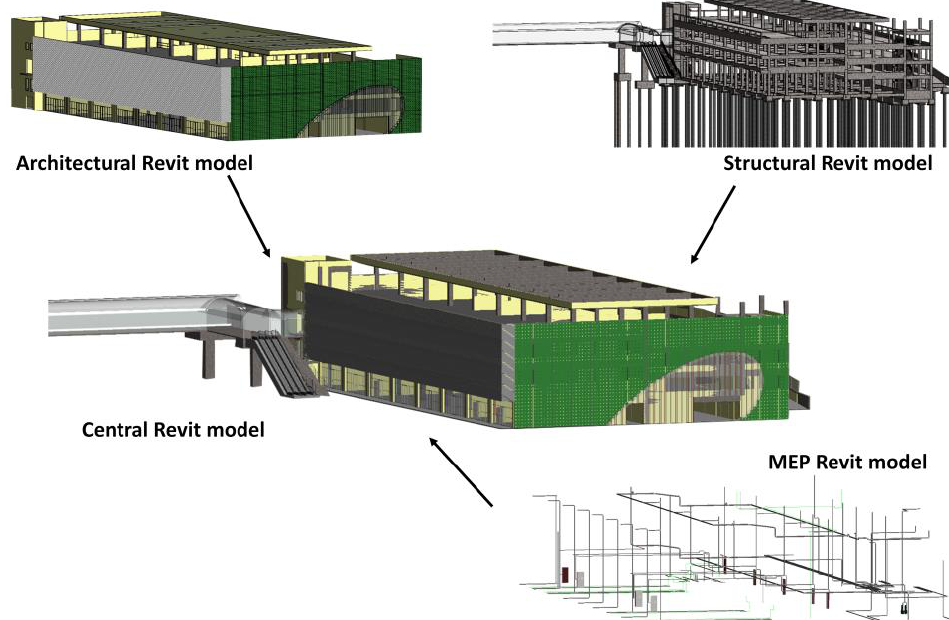
Figure 8. Central Revit model of a parking lot.